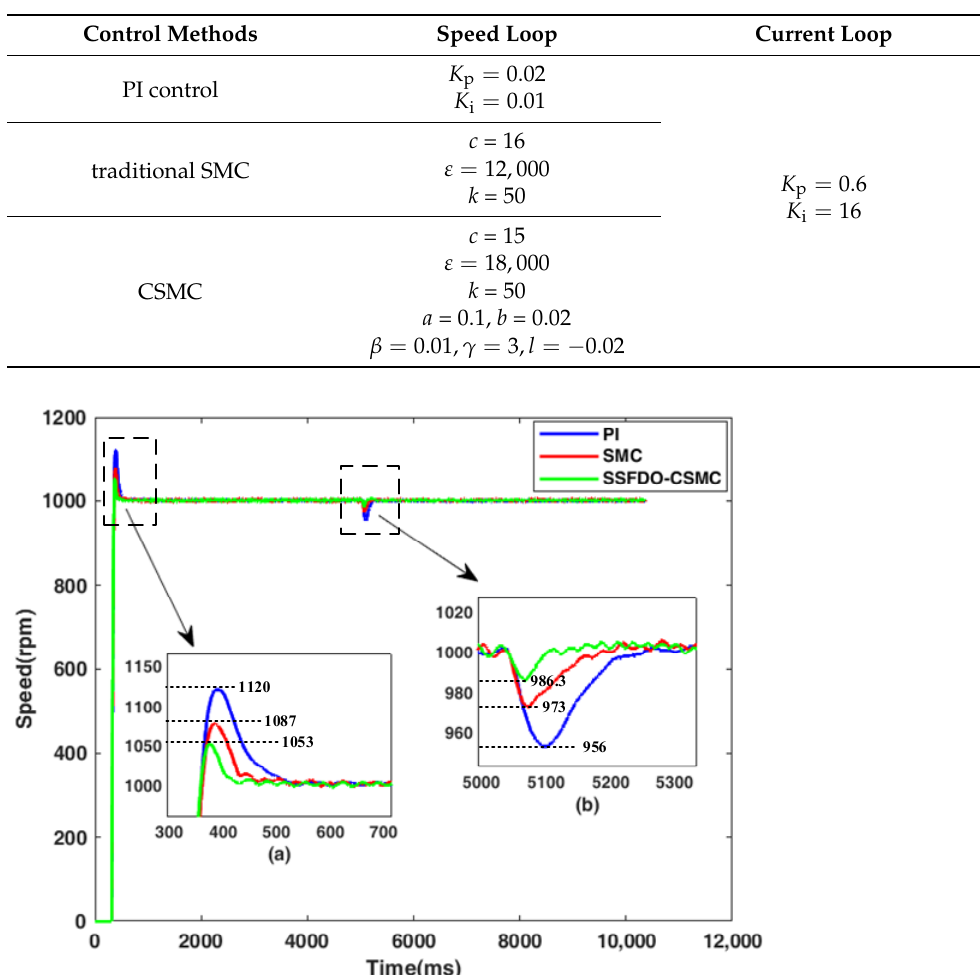
Table 5. Gain parameters of three control methods in the experimental test.